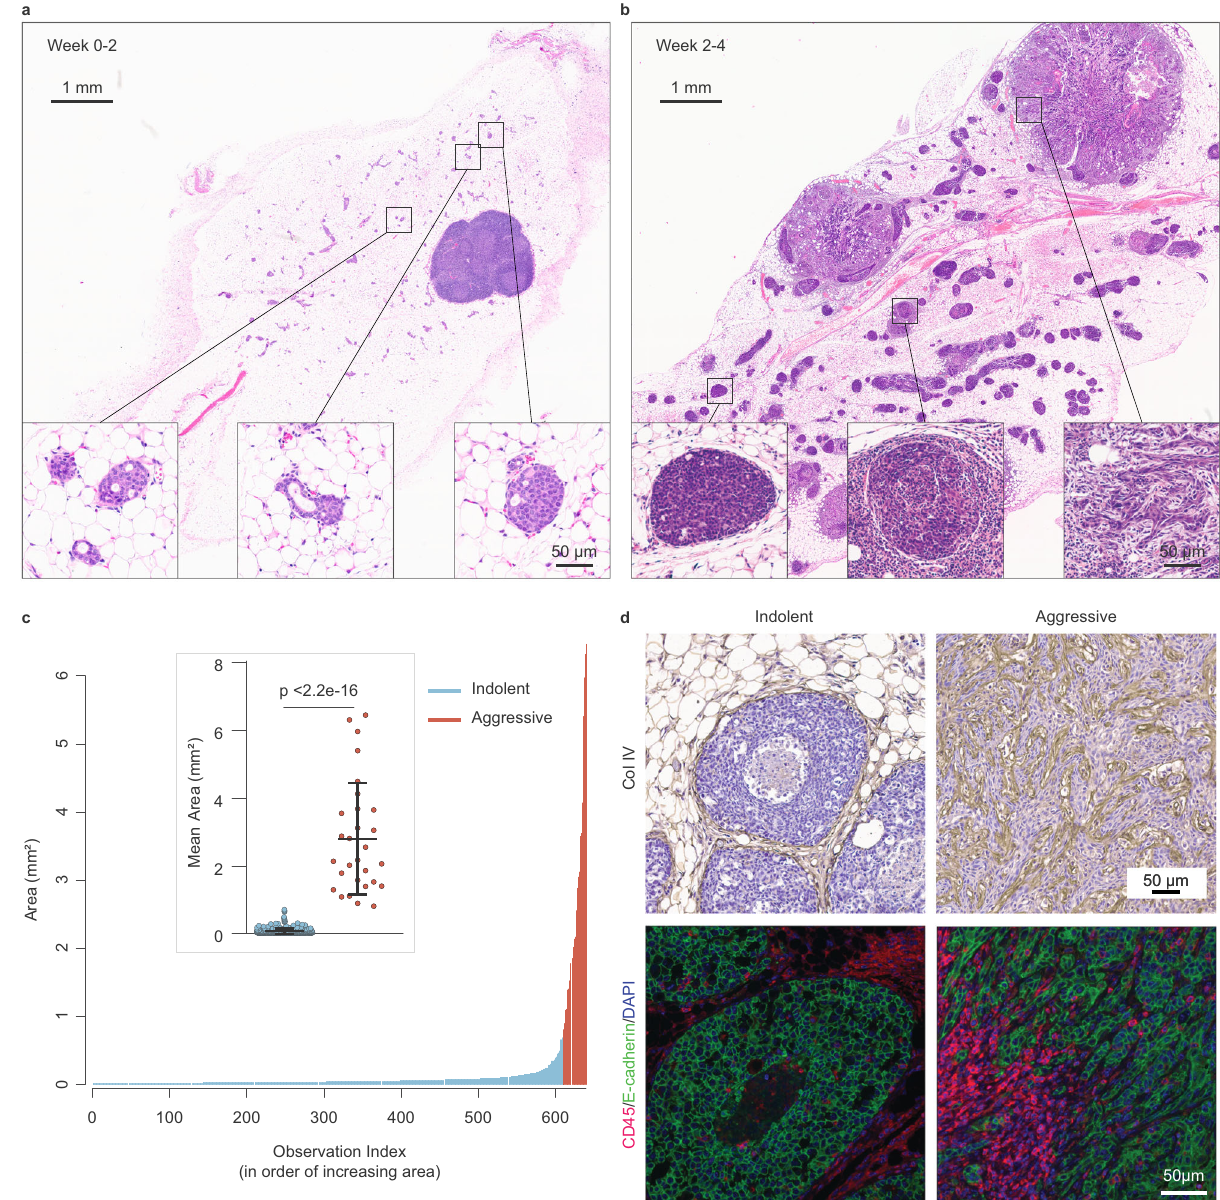
Fig. 1 Aggressive progression occurs in a minority of breast lesions and is associated with heavy immune in fi ltration. a , b Mouse model of breast cancer exhibits the progression of mammary lesions over time. Mammary glands were collected from animals at various time points following intraductal injection and stained by hematoxylin & eosin (H&E) to visualize lesions at 0 – 2 weeks ( a ) or 2 – 4 weeks ( b ) after injection. High-power magni fi cation (inset) shows in situ lesions of early time points ( a ), and a combination of in situ (indolent; b, left inset) and invasive (aggressive; b , right inset) lesions at later time points. Lesions exhibiting a well-circumscribed tumor compartment with heavy stromal involvement ( b , center inset) were also observed. c Quanti fi cation of lesions present 2 – 4 weeks after injection reveals minority of rapidly progressing large lesions. Mammary glands bearing a combination of indolent and aggressive lesions were evaluated for individual lesion size. Index plot shows all lesions quanti fi ed across fi ve animals. Inset dot plot shows mean area of top 5% largest lesions vs. remainder. P value (<2.2e − 16) was calculated using two-sided Wilcoxon rank sum test for non-normal data; center line, mean; error bars, standard deviation (SD), U = 0. d Aggressive lesions are heavily immune in fi ltrated. Lesion-bearing glands were immunostained for collagen IV (top panel) and E-cadherin/CD45 (bottom panel) to assess, respectively, integrity of basement membrane and associated immune in fi ltration of indolent and aggressive lesions. Representative results from n = 3 independent animals. See also Supplementary Fig. 1. Source data are provided as a Source Data fi Fig. 2d – g), and also did not display gene set enrichment for the associated pathways (Fig. 2d) despite heavy immune in fi ltration ERBB signaling pathway (Supplementary Fig. 2h), suggesting that into these lesions (Fig. 1d, bottom panel), suggesting that aggressive lesions may be less dependent on ERBB signaling for aggressive tumor cells may be capable of dampening anti-tumor continued aggressive behavior. Finally, to evaluate the intrinsic immunity. Notably, aggressive lesions expressed ERBB family subtypes of breast cancer(s) most represented by our model, we members at comparable ( Erbb2 and Egfr) or lower ( Erbb3 and performed PAM50 analysis on the transcriptional pro fi les of Erbb4 ) levels compared to indolent lesions (Supplementary